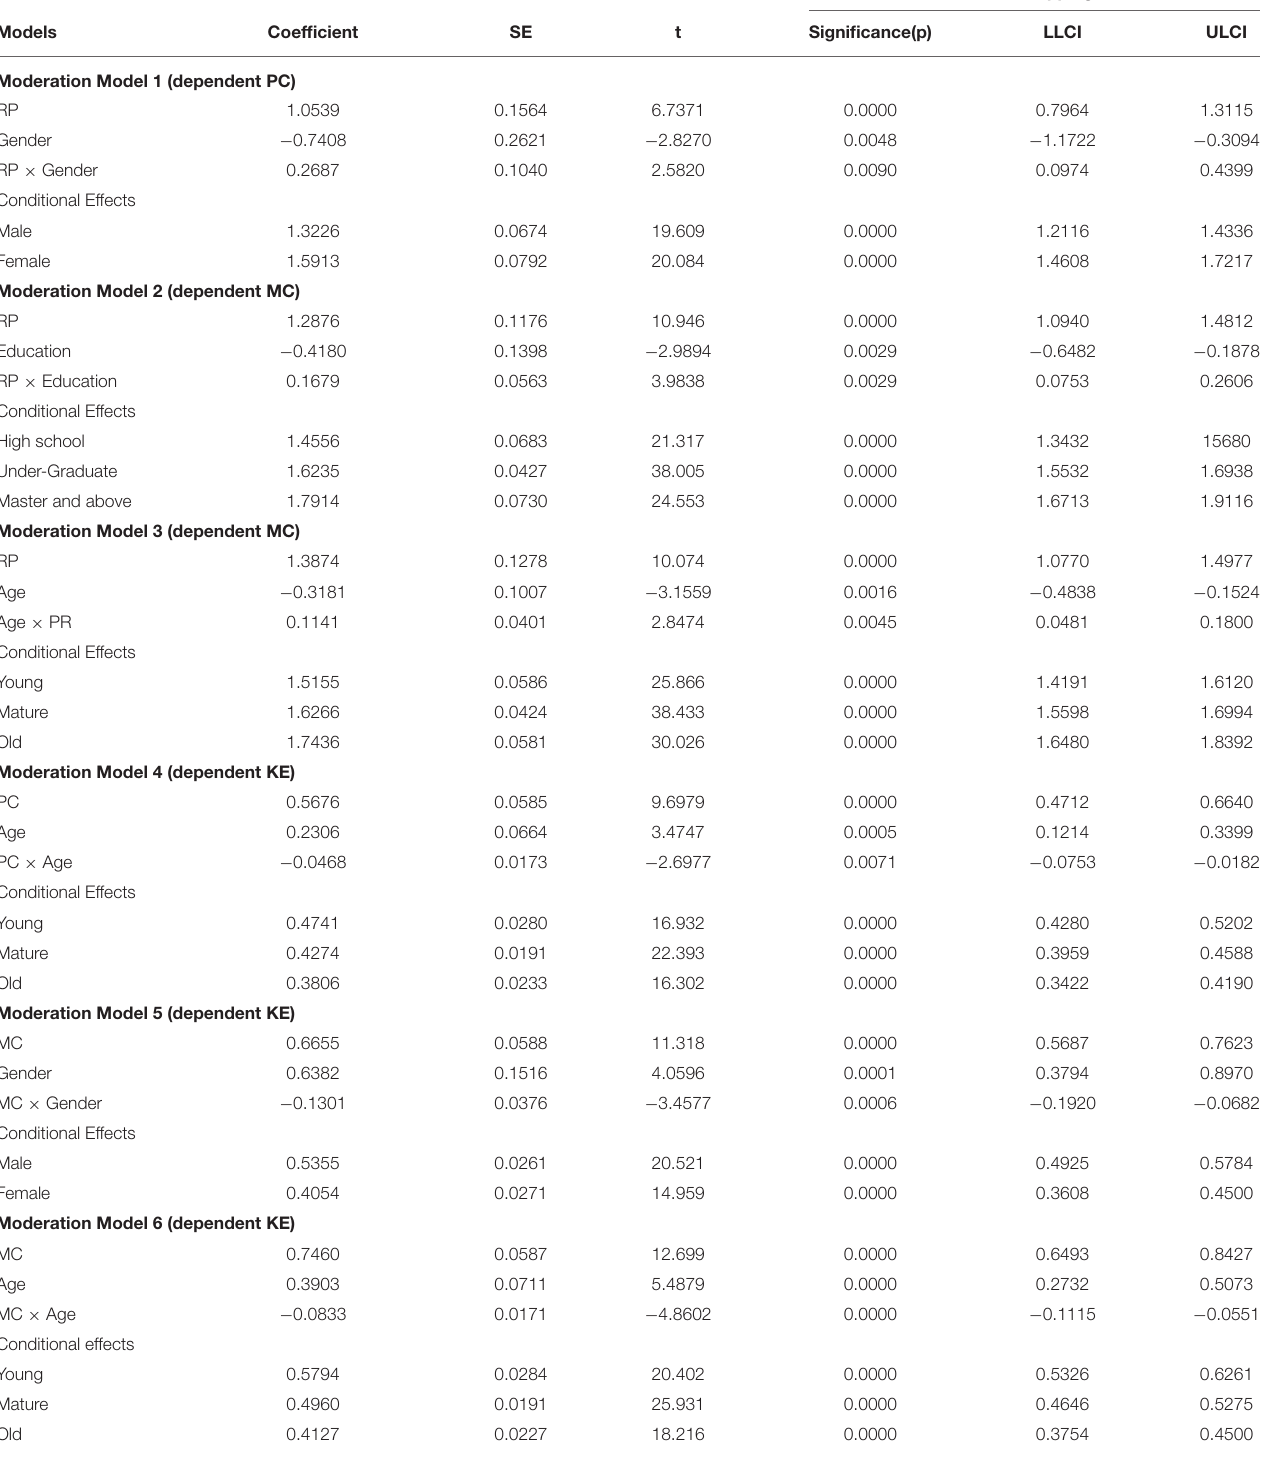
TABLE 6 | Moderation